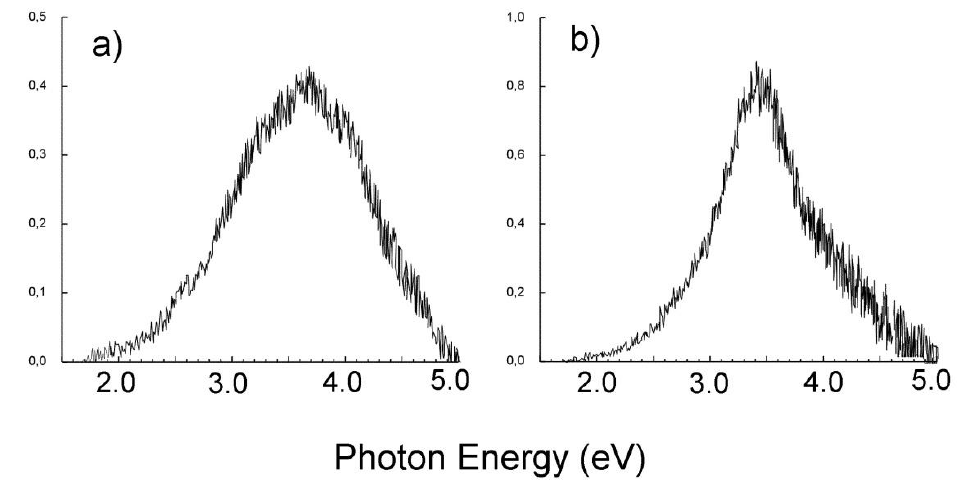
Figure 14. Cathodoluminescence spectra at 295 K of Li ( a ) and doped with Cu (0.015%) ( b ). Adapted from